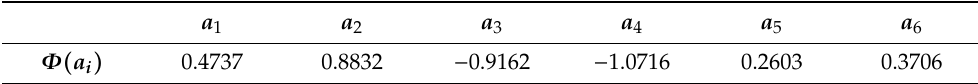
Table 4. The global outranking